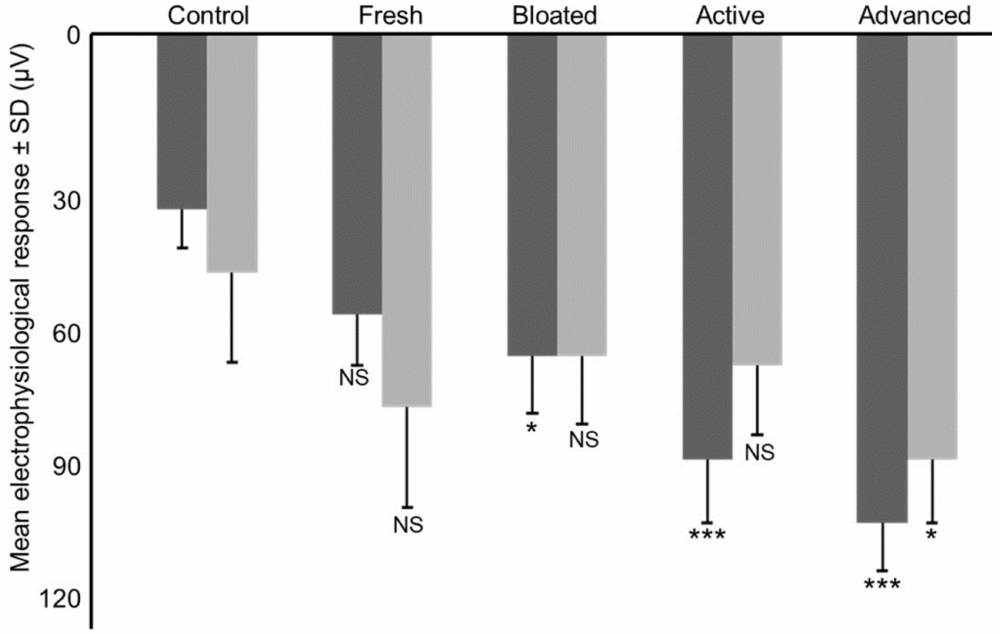
Figure 3. Mean electrophysiological response of male (dark grey) and female (light grey) antennae towards the scent of the di ff erent stages of decomposition ( µ V ± SD). *** p < 0.001 ; ** p < 0.01 ; * p < 0.05 ; NS Not Significant